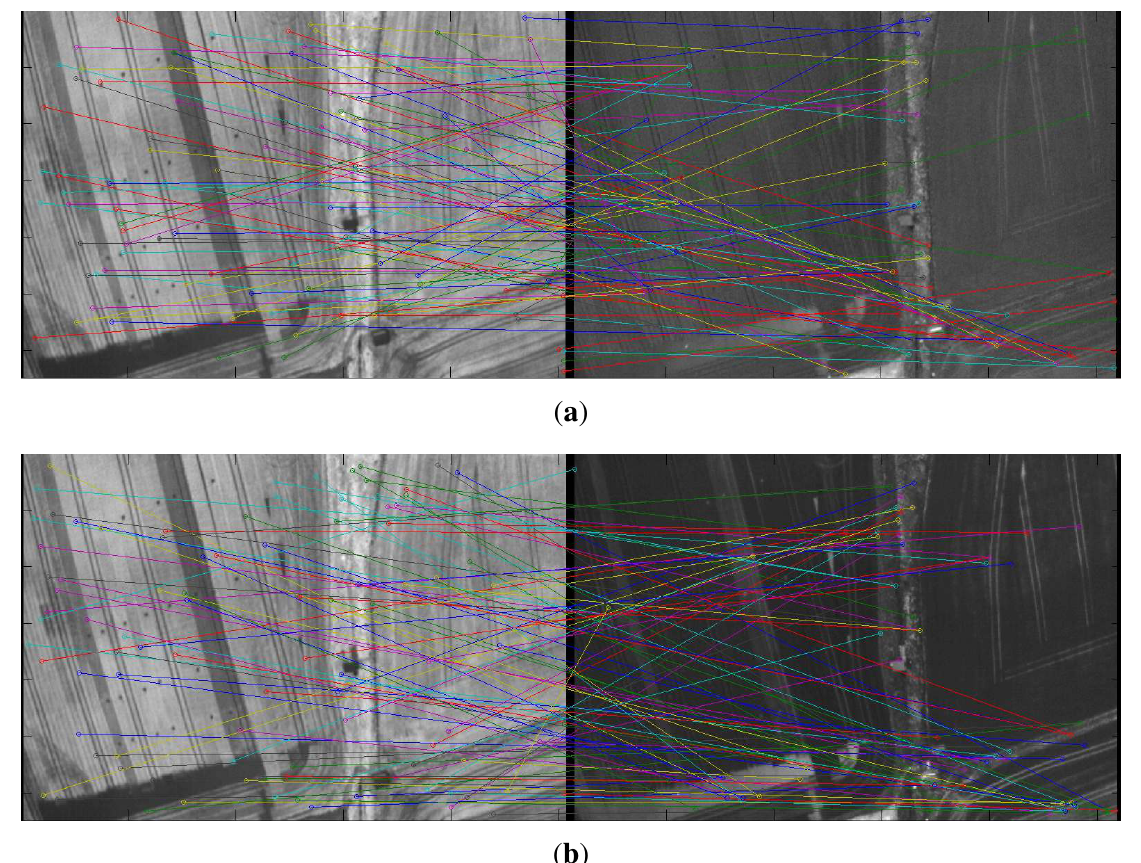
( a ) Correspondences between bands at 783 nm (left) and at 508 nm (right) based on scale invariant feature transform (SIFT) and RANSAC; ( b ) Correspondences between bands at 783 nm (left) and at 657 nm (right) based on SIFT and